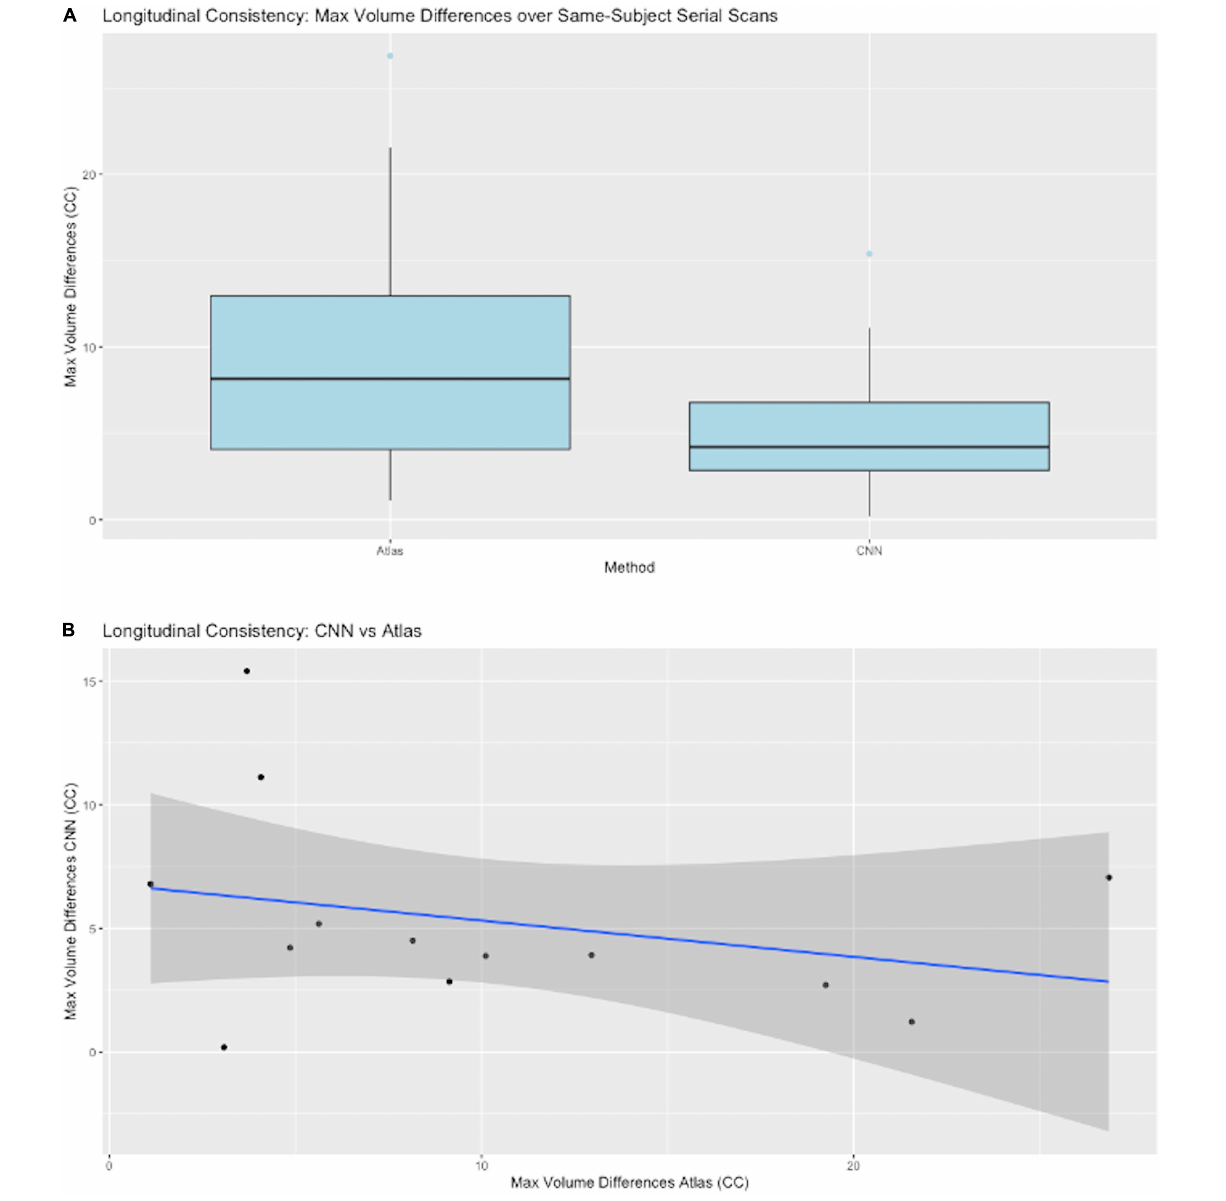
resemblance (HD) and reduced human cleanup times to fill in or erase incorrect labeling. (4) The CNN predictions attain excellent longitudinal consistency that exceeds the performance of atlas- based ground truth sets ( Figure 7 ). The CNN predictions attained median volumetric ICC differences over same-subject scans of about 4 cm 3 ( Figure 7 ) or roughly 0.4% in a putative brain of 1000 cm 3 , suggesting that analyses based on these outputs could offer excellent statistical power.